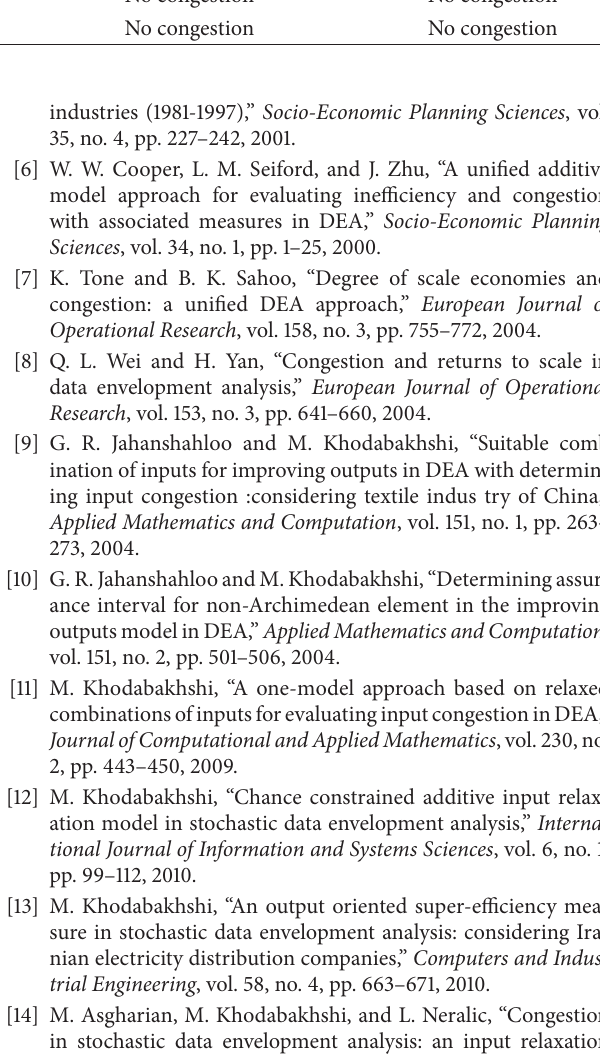
Results of the proposed Results of Cooper et al.’s approach in 𝑇 approach in 𝑇 FDH BCC